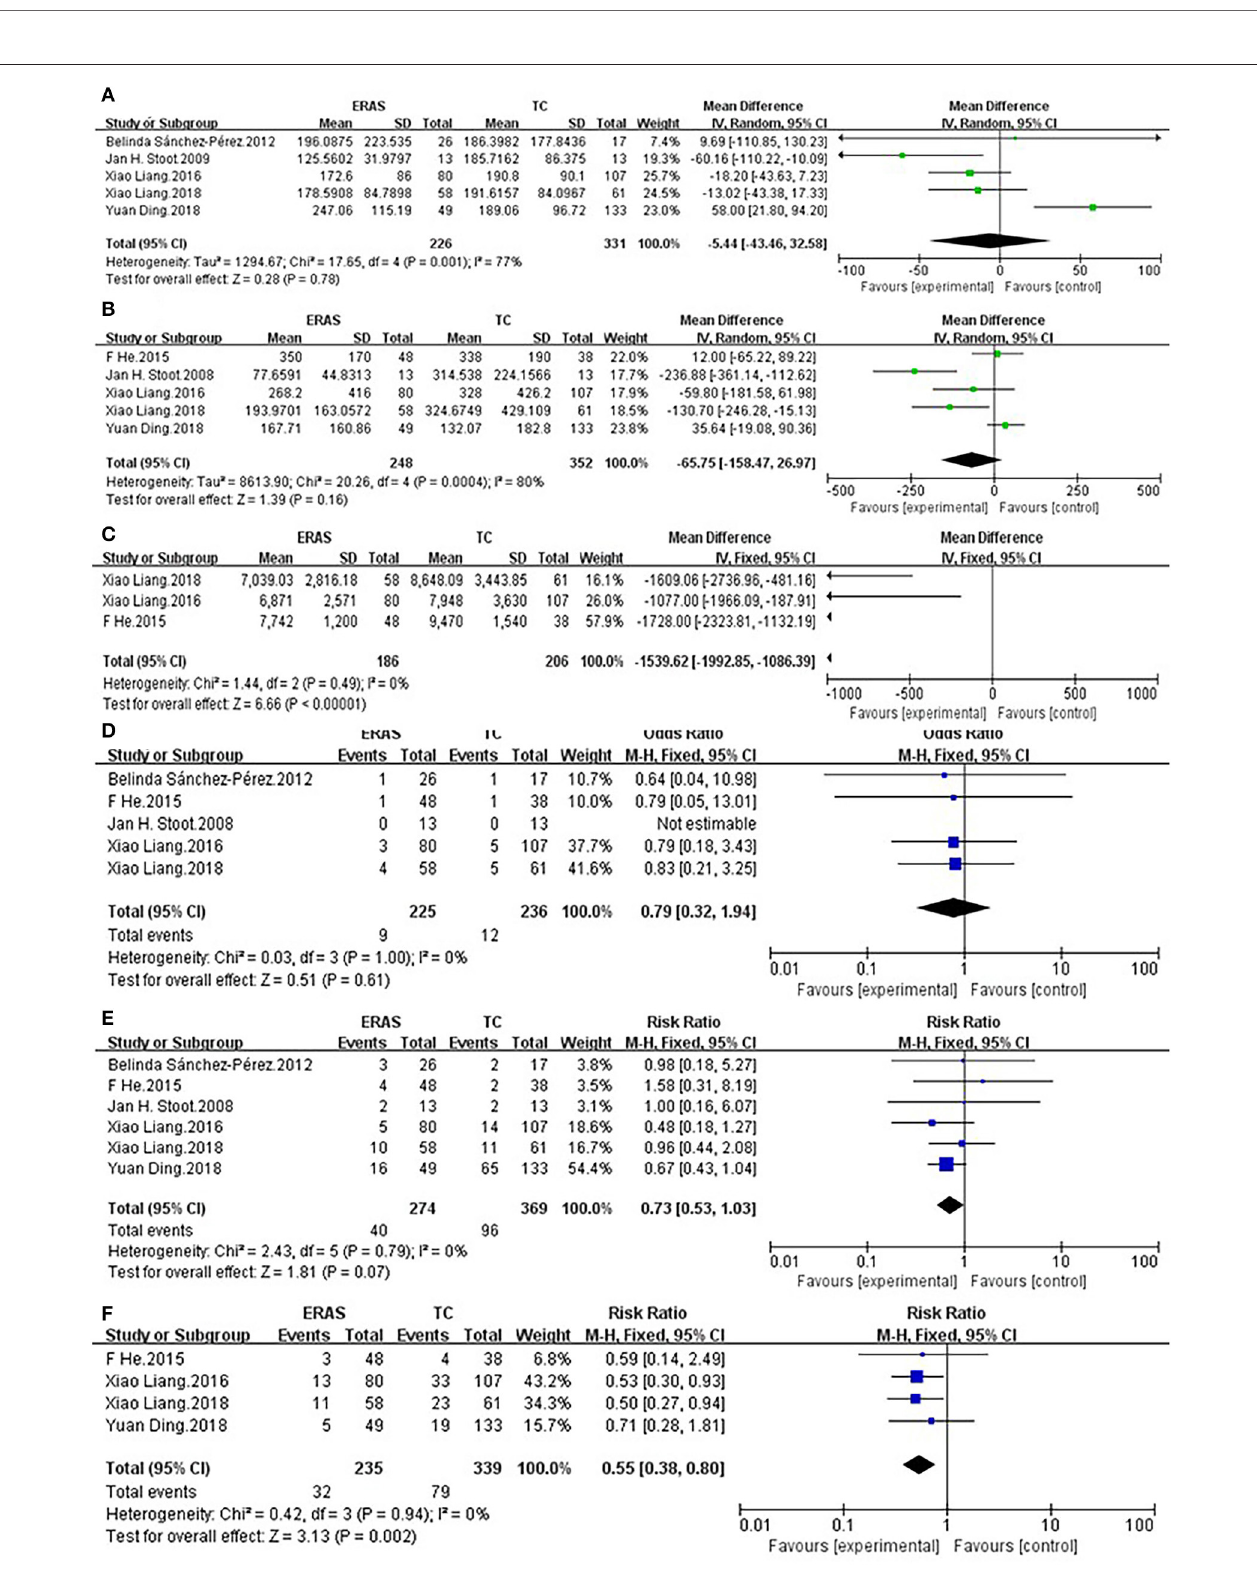
FIGURE 3 | Comparisons of secondary outcomes after ERAS or TC in patients undergoing laparoscopic hepatectomy. The differences in (A) operative time, (B) intraoperative blood loss, (C) cost of hospitalization, (D) readmission rate, (E) Grade I complication rate, and (F) Grade II–V complication rate.